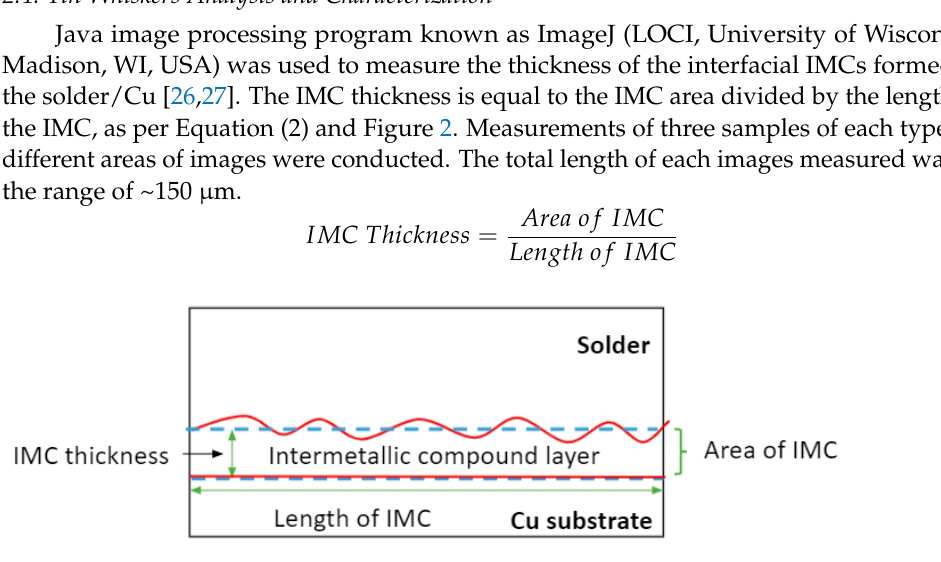
Figure 2. The calculation of the IMC’s thickness.